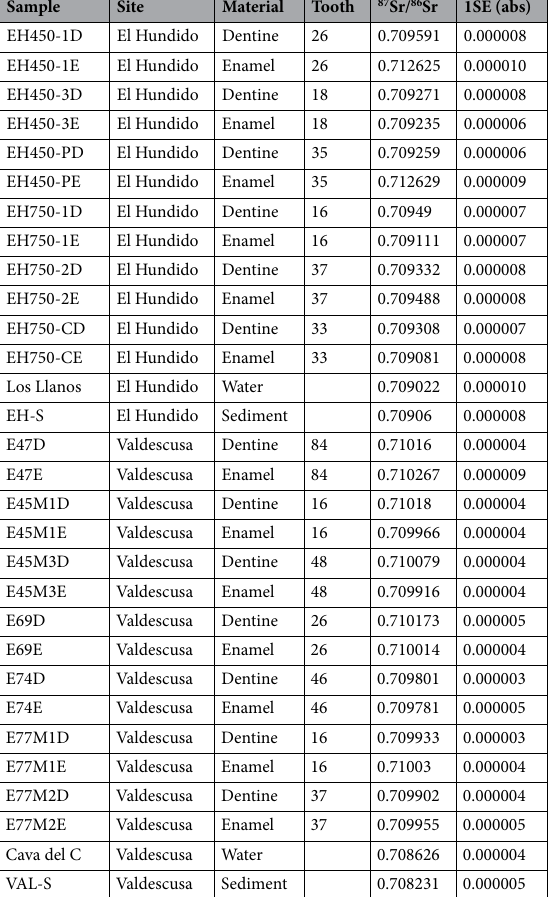
Table 2. Values of strontium isotopes ratios of enamel and dentine samples with standard error.